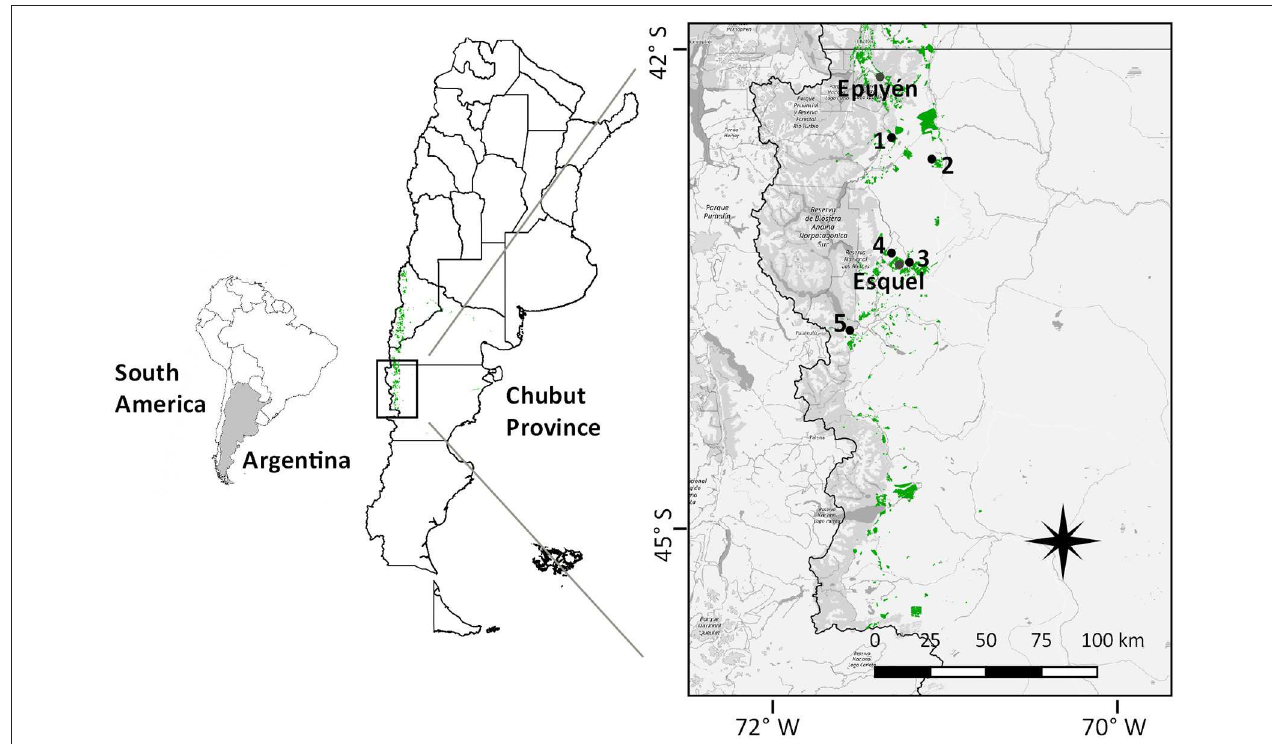
FIGURE 1 | Conifer plantations location (green) along NW Chubut Province, Argentina, showing the five study sites. Andean–Patagonian forests distribution is represented in dark gray.